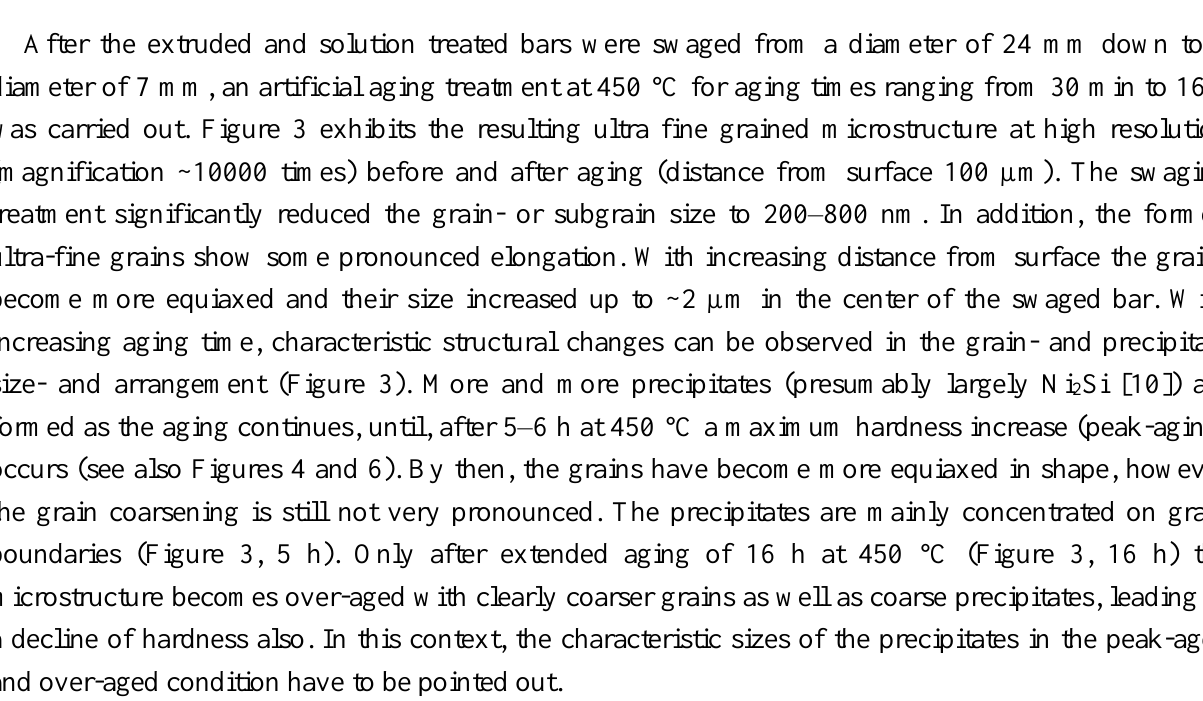
Figure 2. Hardness evolution of solution treated CuNi3Si1Mg by